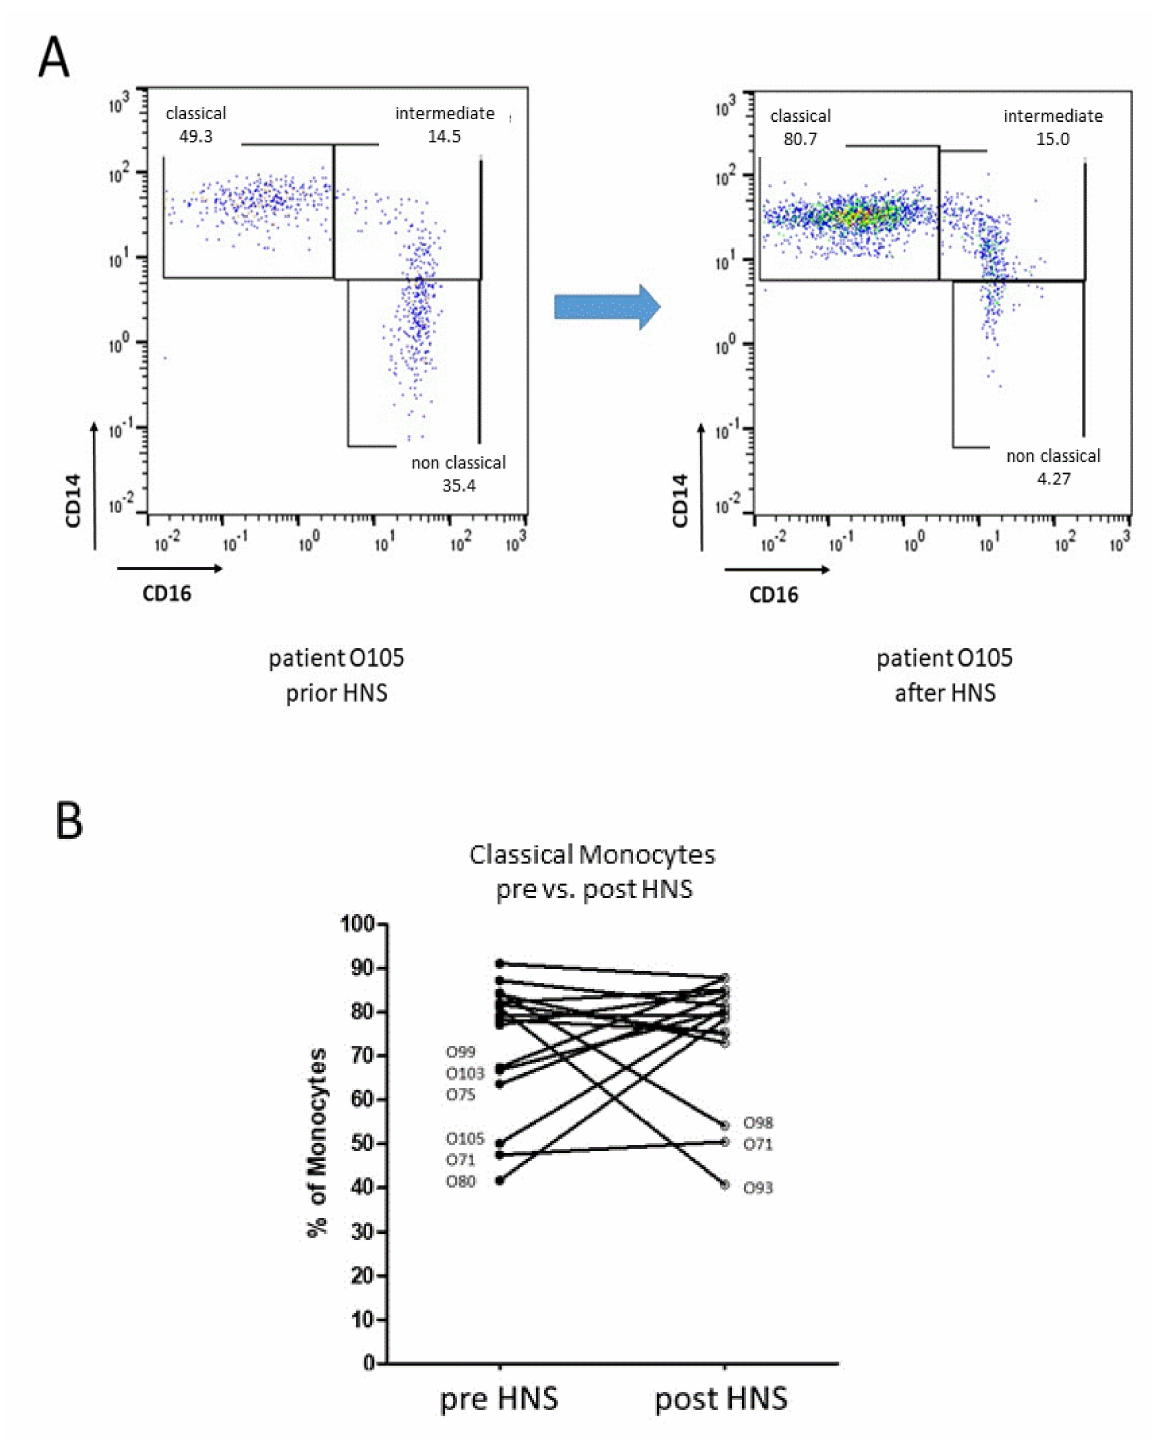
Figure 4. Flow cytometric analysis of classical monocytes before (pre) and after (post) HNS treatment. ( A ): Example flow cytometry gating scheme of peripheral monocyte subsets of patient O105 before and after 12-month HNS treatment. ( B ): Whole blood analysis revealed an improvement in five patients, a decrease in classical monocytes in two patients, and an unchanged level in one patient upon HNS treatment. Patients’ numbers are given in case of redistributed monocyte